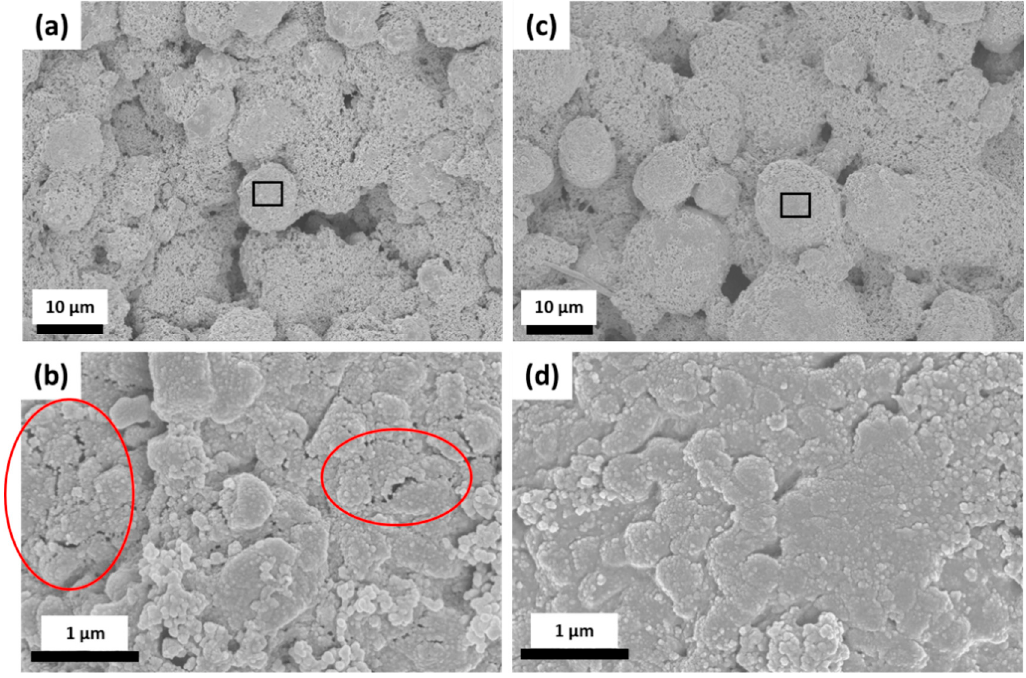
Figure 8. SEM images for cycled Electrode: ( a , b ) Pristine ( c , d ) SiO 2 -coated NMC622.